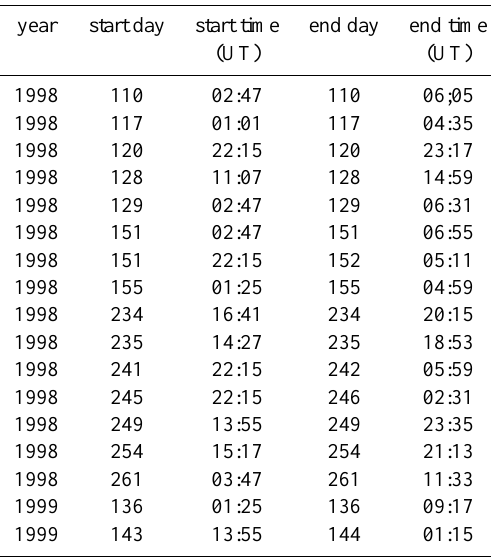
Table 2. Magnetopause-crossing intervals from the Geotail space- craft.